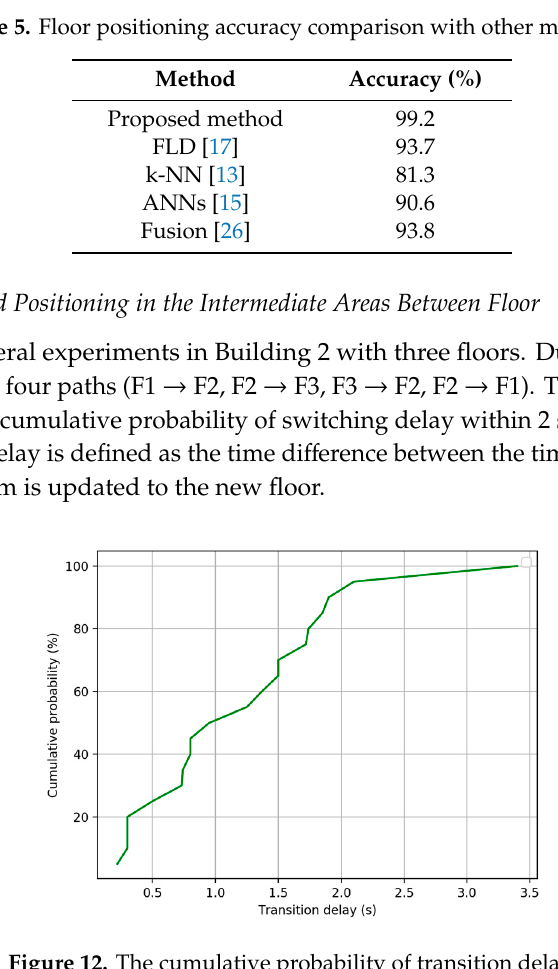
Table 6. Comparison of different algorithms training and testing time. Model